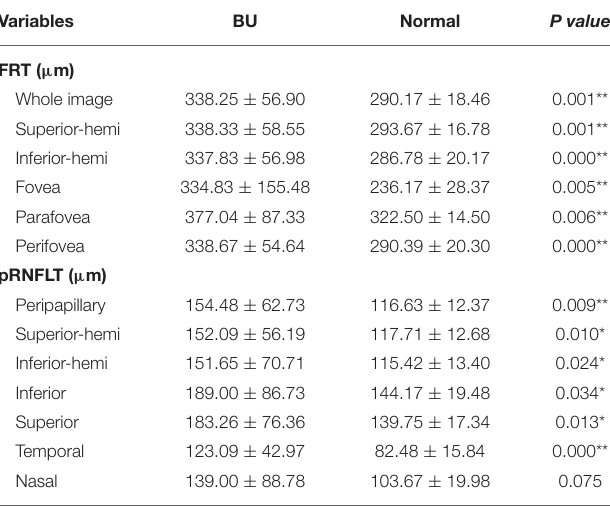
TABLE 4 | Comparison of FRT and pRNFLT Measurements Evaluated between BU and Normal